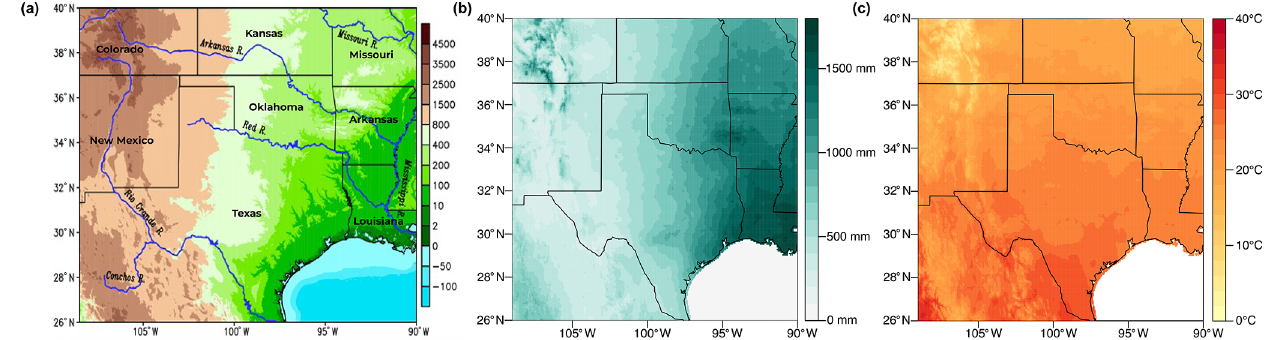
Figure 1. Topographical map for the study domain: the elevation map of the south-central United States with major rivers overlaid on it. (a) Elevation (in units of m), with the rivers outlined in blue. Topography, bathymetry, and shoreline data are obtained from the National Oceanic and Atmospheric Administration (NOAA) National Geophysical Data Center’s ETOPO1 Global Relief Model (Amante and Eakins, 2009). This is a 1arcmin model of the Earth’s surface developed from diverse global and regional digital datasets and then shifted to a common horizontal and vertical datum. River shapefiles are obtained from the Global Runoff Data Centre’s Major River Basins of the World (GRDC, 2020). (b) Study domain overlaid with annual average precipitation (mm) from Livneh v. 1.2 (Livneh et al., 2013). (c) Study domain overlaid with annual high temperatures ( ◦ C) from Livneh v. 1.2 (Livneh et al.,